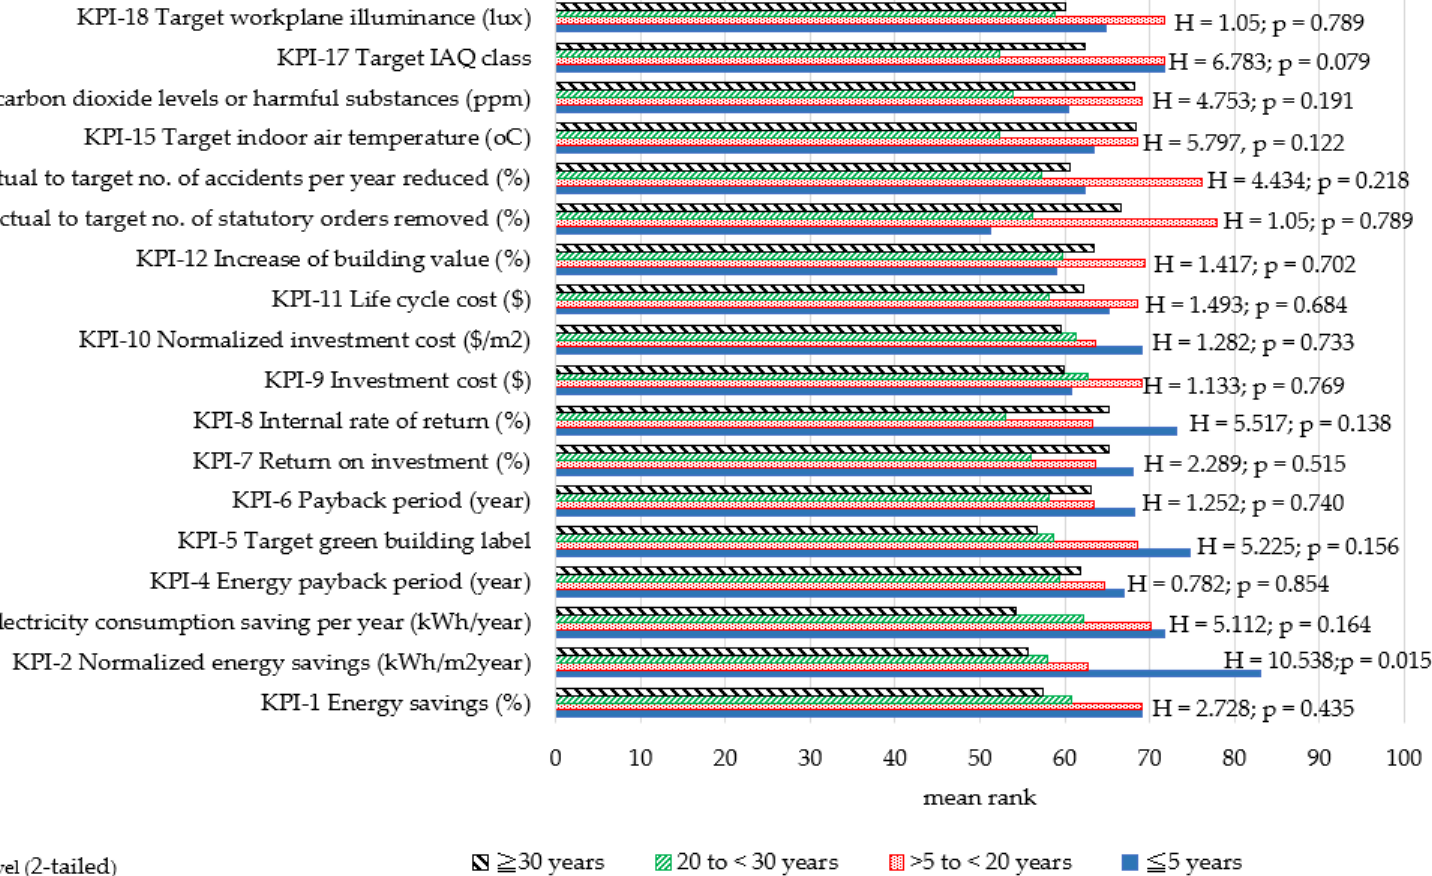
Figure A1. Kruskal–Wallis H-test results of G2 (work Figure A1. Kruskal – Wallis H-test results of G2 (work experience).